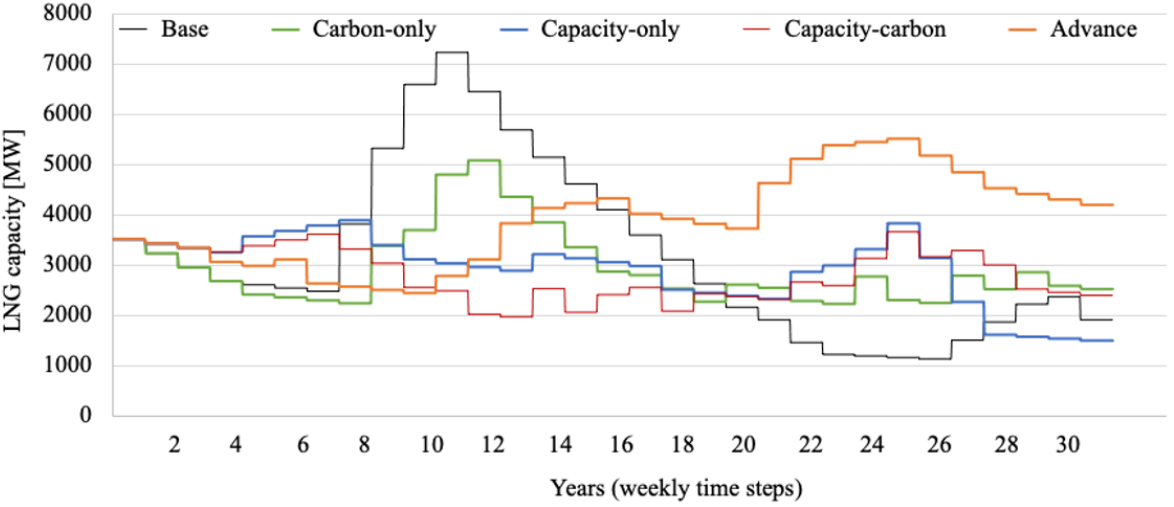
Figure 11. The trajectory of NG power plant capacity change.